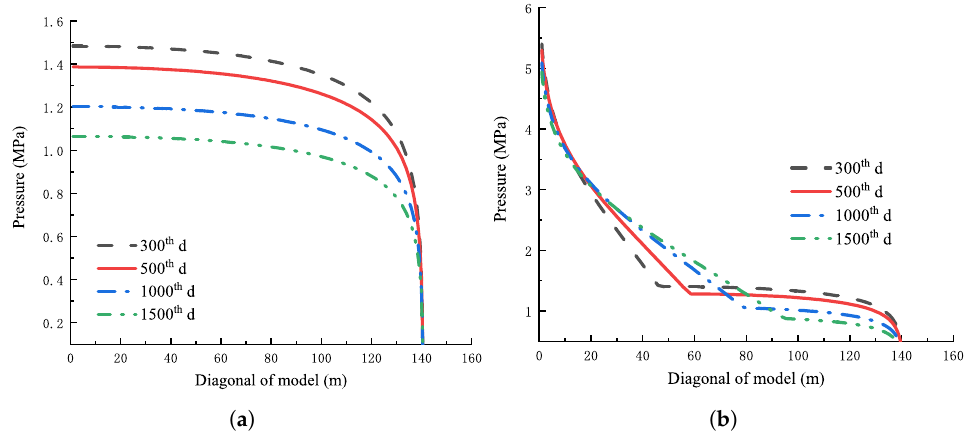
Figure 8. Distribution curve of reservoir gas pressure along the model diagonal ( a ) CBM ( b ) CO 2 - ECBM